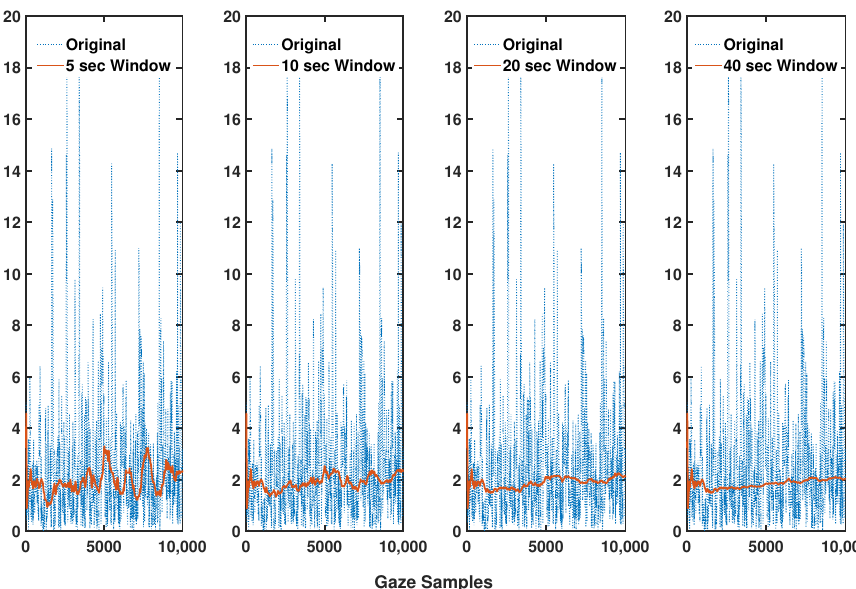
Figure 6. Original gaze samples (blue) and different moving window medians applied to the original data smoothing the saccades